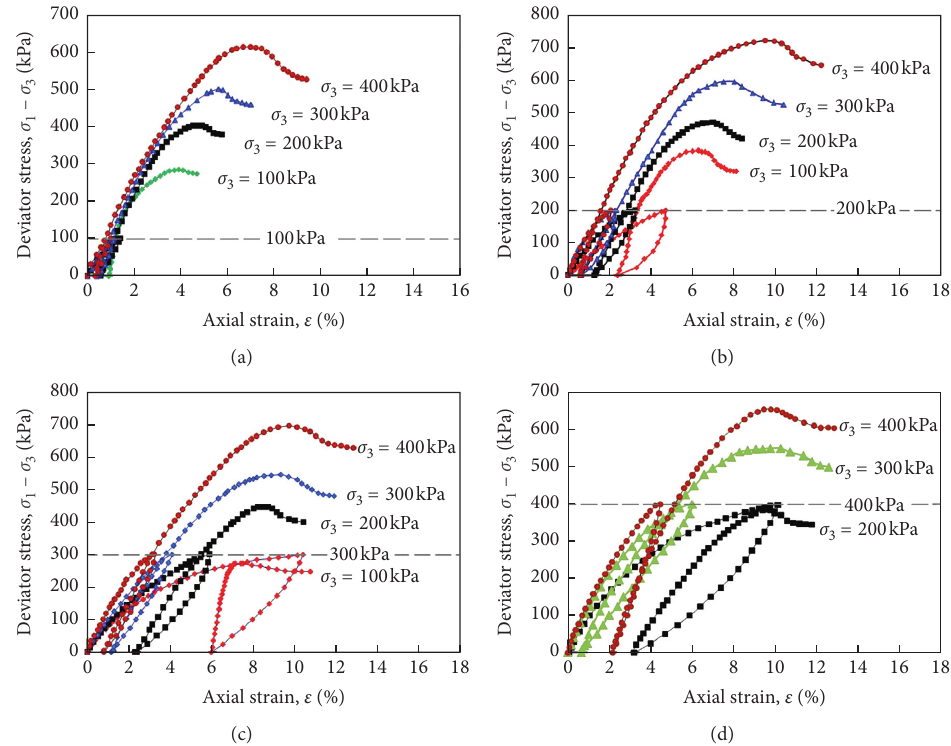
Figure 6: Stress-strain curves of CDG soil at different confining pressures. (a) σ (d) σ 1 − σ 3 �